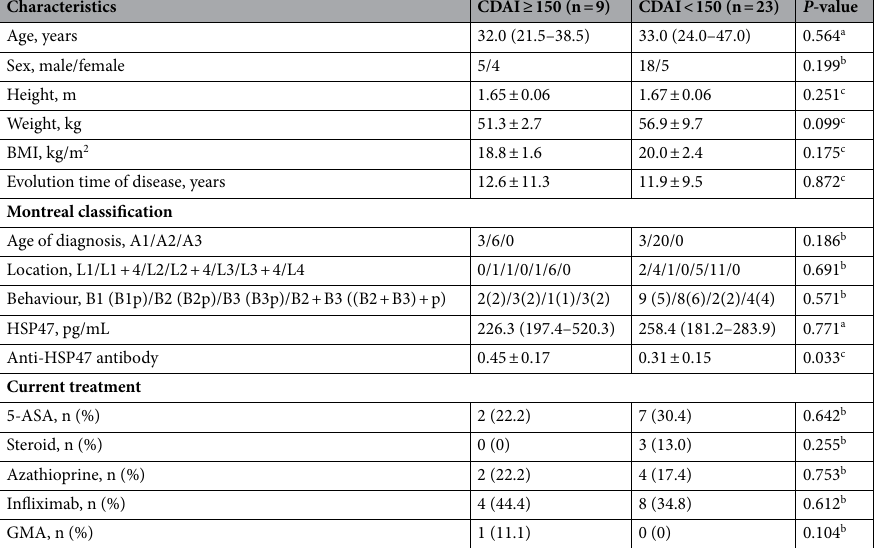
Table 2. Characteristics of patients with CD by disease activity. Montreal classification of CD: A1, age < 16 years; A2, age 17–40 years, A3, age > 40 years. L1 ileal, L2 colonic, L3 ileocolonic, L4 isolated upper disease, B1 non-structing and non-penetrating, B2 structing, B3 penetrating, p perianal, CDAI Crohn’s disease activity index, BMI body mass index, HSP heat shock protein, GMA granulocyte–monocyte apheresis. a Mann– Whitney U test; b Chi-square test; c Student’s t